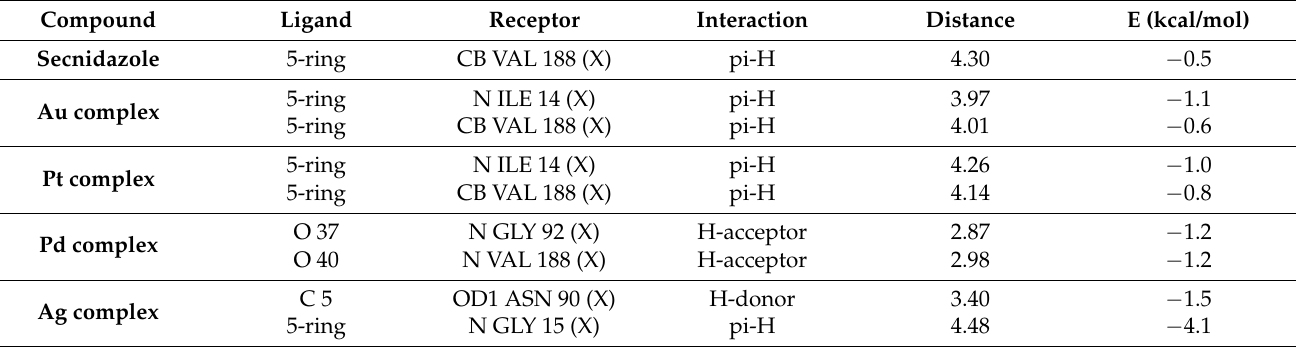
Table 14. Docking interaction of the ligand and its metal complexes with 3hb5